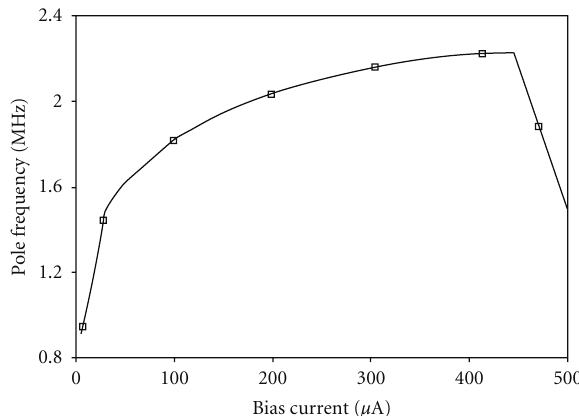
Figure 7: Response of band-pass filter for constant Q 0 = 1 and di ff erent f 0 .